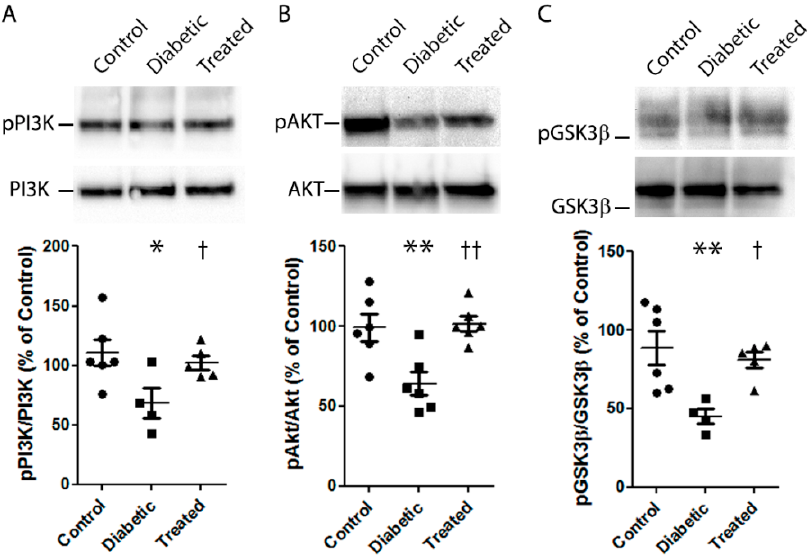
Figure 6. Effect of pterostilbene on the PI3K/AKT/GSK3 β /NRF2 pathway. Type 1 diabetes mellitus and Pter treatment were performed as described in Figure 2. A Western blot was used to detect the expressions of pPI3K/PI3K ( A ), pAKT/AKT ( B ), pGSK3 β /GSK3 β ( C ). Data are presented as mean ± SEM (at least n = 4 in each group). An ANOVA, followed by a Newman–Keuls post hoc test, was used to assess any significant differences between the experimental conditions. * p < 0.05; ** p < 0.01 versus the control group. † p < 0.05; †† p < 0.01 versus the diabetic group.